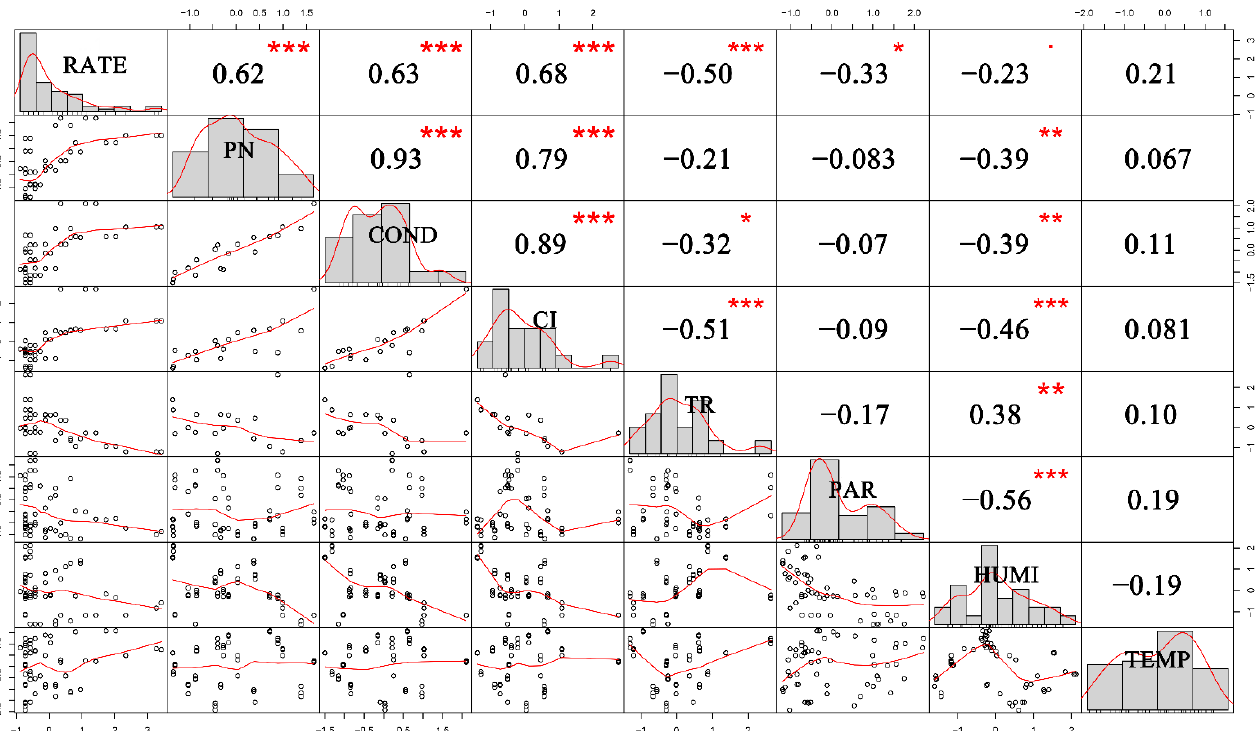
Figure 4. Correlation matrix of variables measured (*** p < 0.001; ** p < 0.01; * p < 0.05). The data has been standardized. RATE = isoprene emission rate; PN = net photosynthesis rate; COND = stomatal conductance; CI = intercellular CO 2 concentration; TR = transpiration rate; PAR = photosynthetically active radiation; HUMI = humidity; TEMP = temperature.